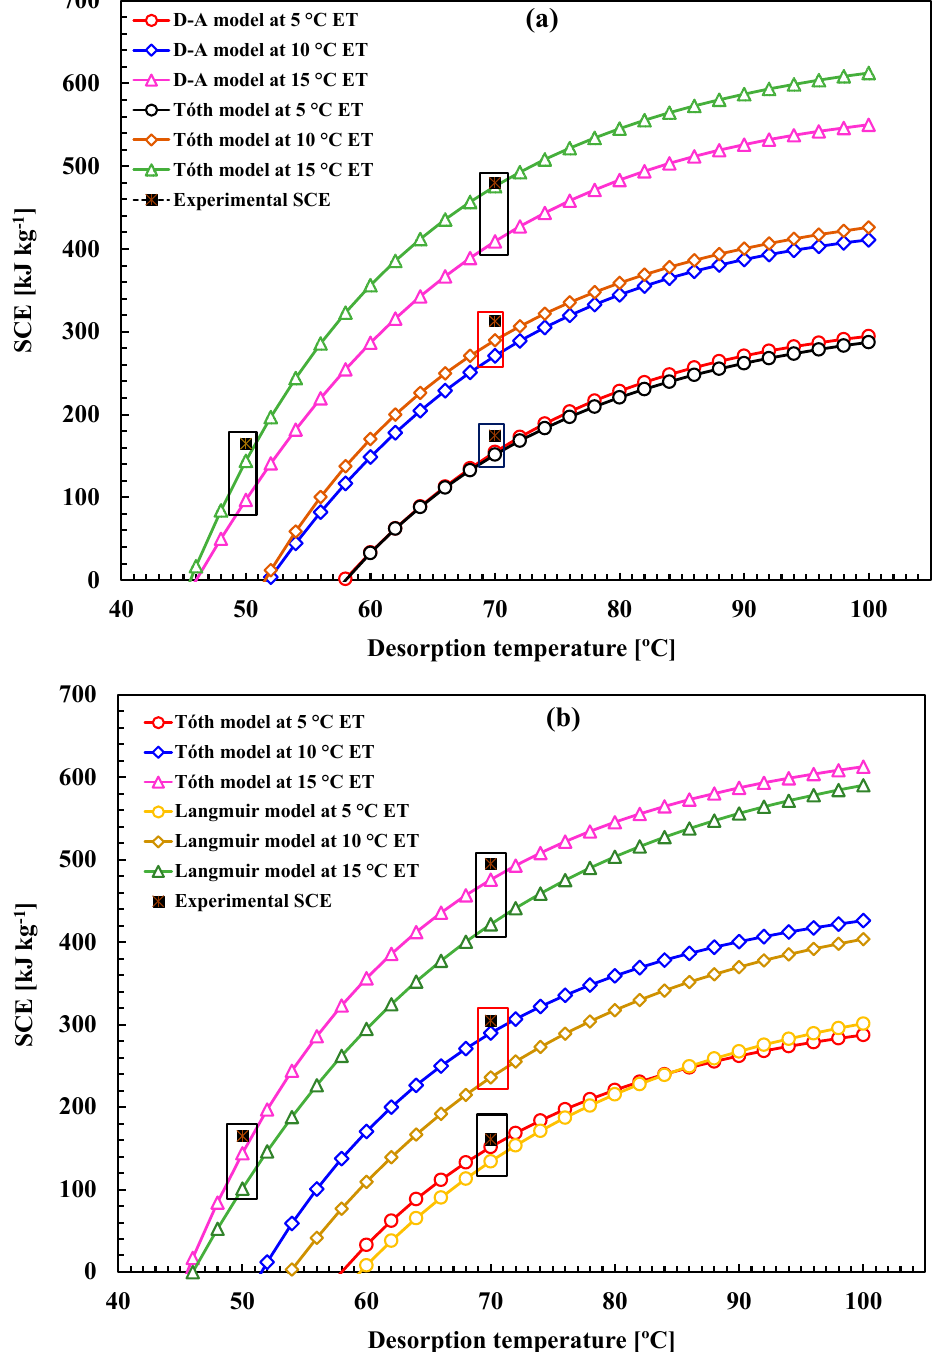
Figure 5. Experimental SCE comparisons with ( a ) Tóth vs. D-A models and ( b ) Tóth vs. Langmuir models of Silica gel/water adsorption pair for different evaporating temperatures.